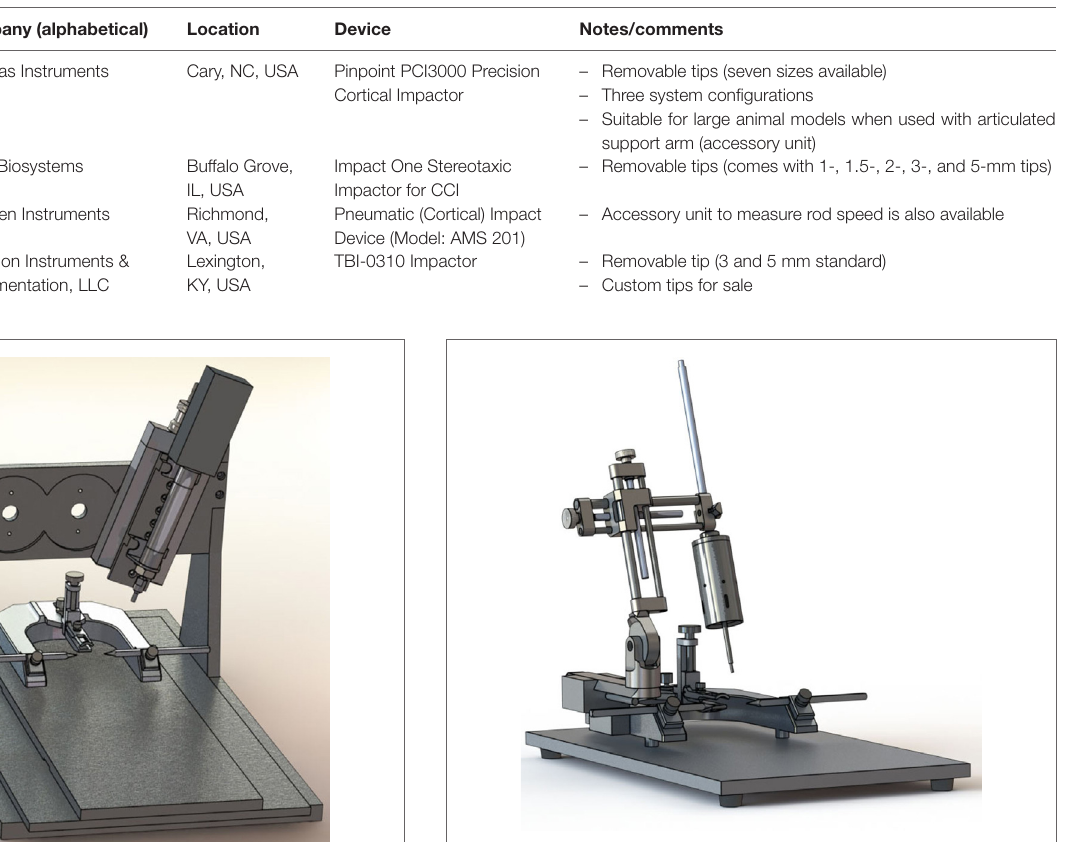
Precision instruments, Pittsburgh, PA, USA) .